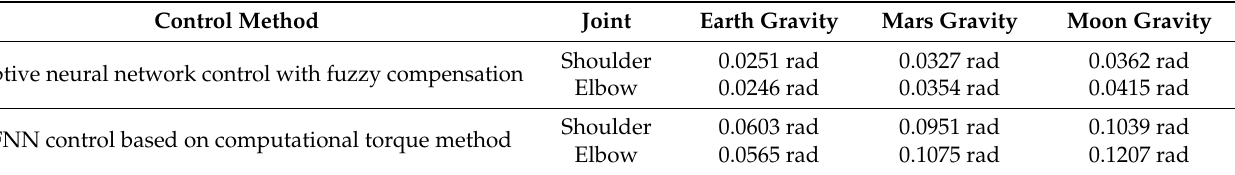
Table 3. The maximum tracking errors in the three gravitational